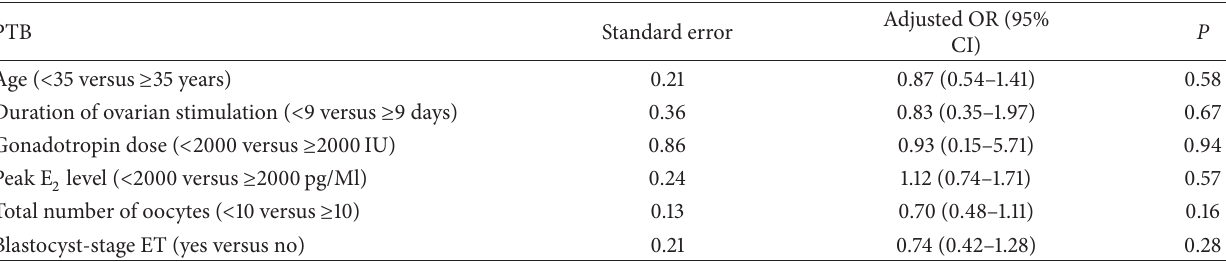
Table 4: Preterm birth and multiple logistic regression to account for confounding variables. PTB